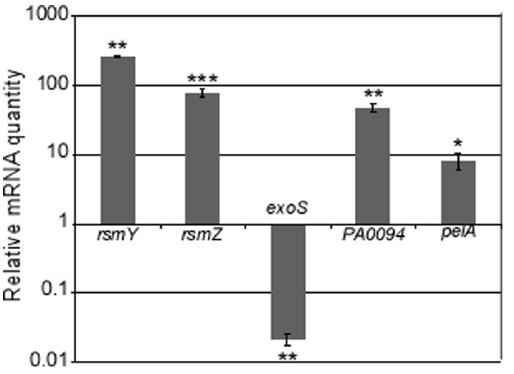
Figure 5. Complementation of CHA with gacS impacts sRNAs transcription as well as amount of major RsmA-target mRNAs, as assessed by RT-qPCR analysis. Relative mRNA quantity compares CHA/pJN-GacS to CHA/pJN105. Positive values indicate that mRNA levels are higher in gacS -complemented CHA. The p-values were calculated with REST2009 using Pair Wise Fixed Reallocation Randomi-